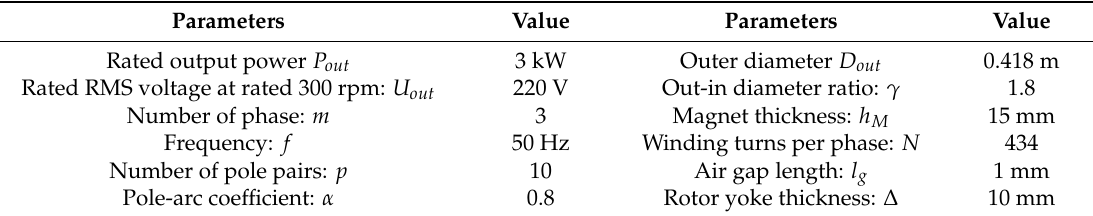
Table 1. Design data of the proposed axial flux permanent synchronous generator (AFPMSG).